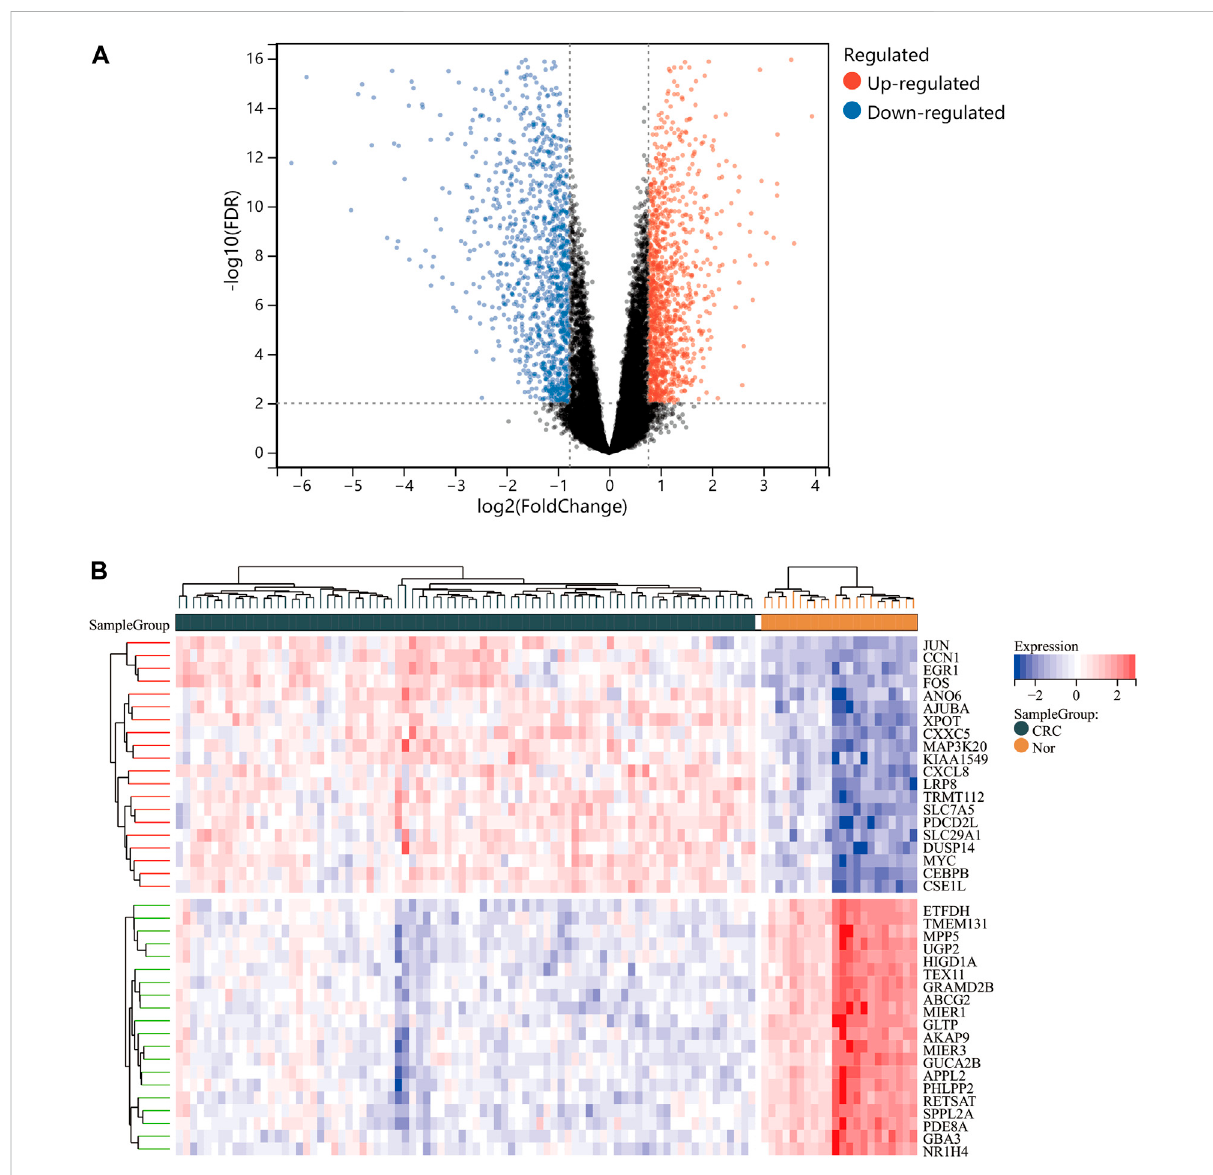
FIGURE 3 Differentially expressed genes (DEGs) for the dataset derived by integrating GSE4107 and GSE9348. Panel (A) , volcano plot depicting the status ofgeneexpression between patients with CRC andnormal controls.Panel (B) ,heatmapof thetop 40DEGs. Regionsinredand bluearedisplayed to distinguish between the up- and down-regulation of